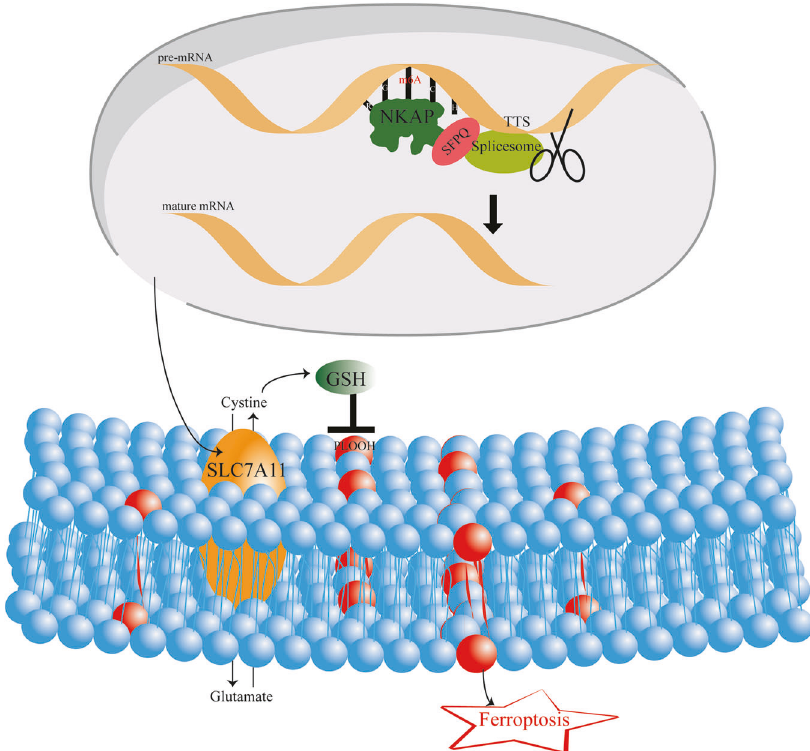
Fig. 7 Pattern diagram of NKAP modulation of ferroptosis. NKAP functions as an m 6 A reader and recruits a splicing complex to promote the TTS event on the SLC7A11 transcript to produce mature mRNA. SLC7A11 anchored in the cytomembrane mediates the entry of cystine to generate GSH, which can neutralize PLOOH and ROS and eventually prevents